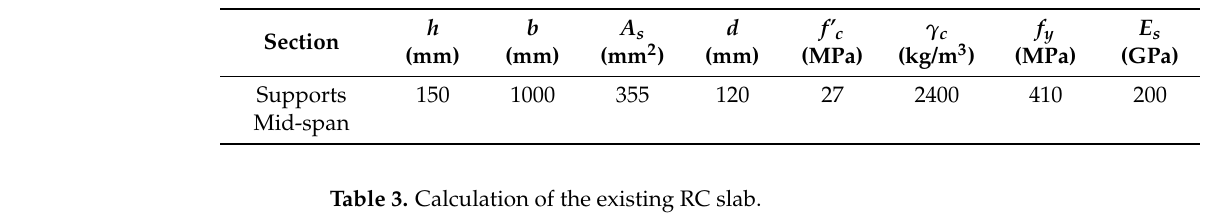
Table 2. The RC slab material properties and dimensions for design example.